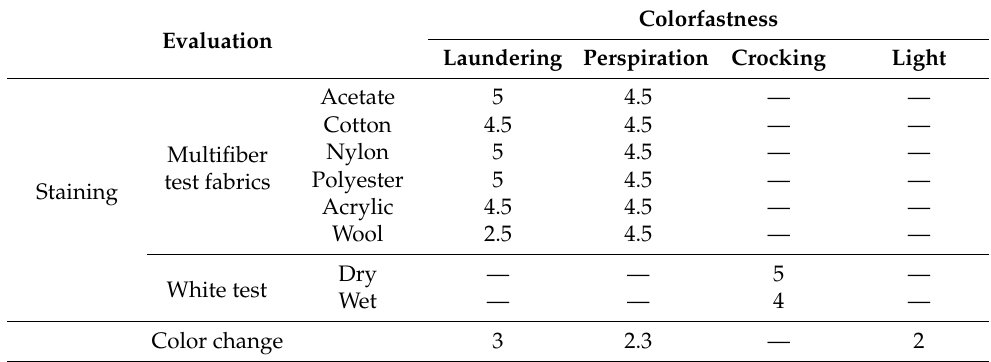
Table 1. Colorfastness of functionalized fabric evaluated with greyscale for color change and staining. Colorfastness Evaluation Laundering Perspiration Crocking Light